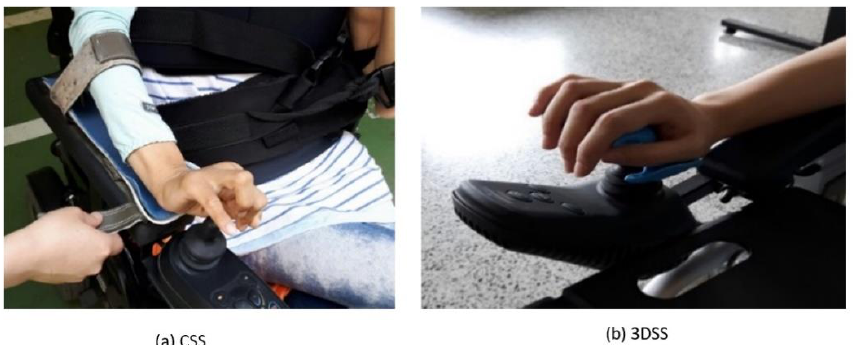
Figure 6. ( a ) Applicating conventional steering controller (CSC); ( b ) Mounted 3D-printed steering controller (3DSC).